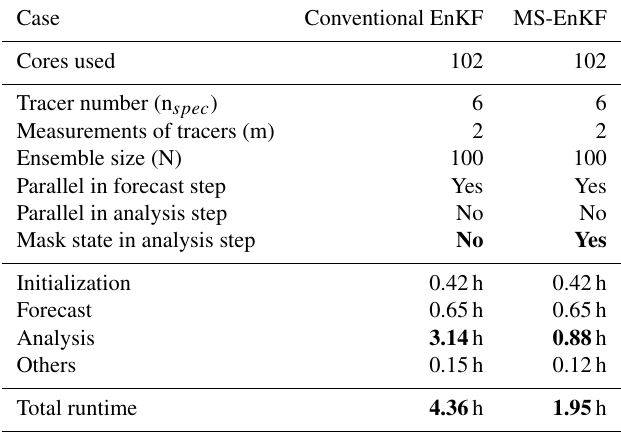
Table 1. Comparison of the computational cost of conventional EnKF and MS-EnKF. (The results are obtained from the bullx B720 thin nodes of the Cartesius cluster, which is a computing facility of SURFsara, the Netherlands Supercomputing Centre. Each node is configured with 2 × 12-core 2.6 GHz Intel Xeon E5-2690 v3 (Haswell) CPUs and with memory 64GB.) Case Conventional EnKF MS-EnKF Cores